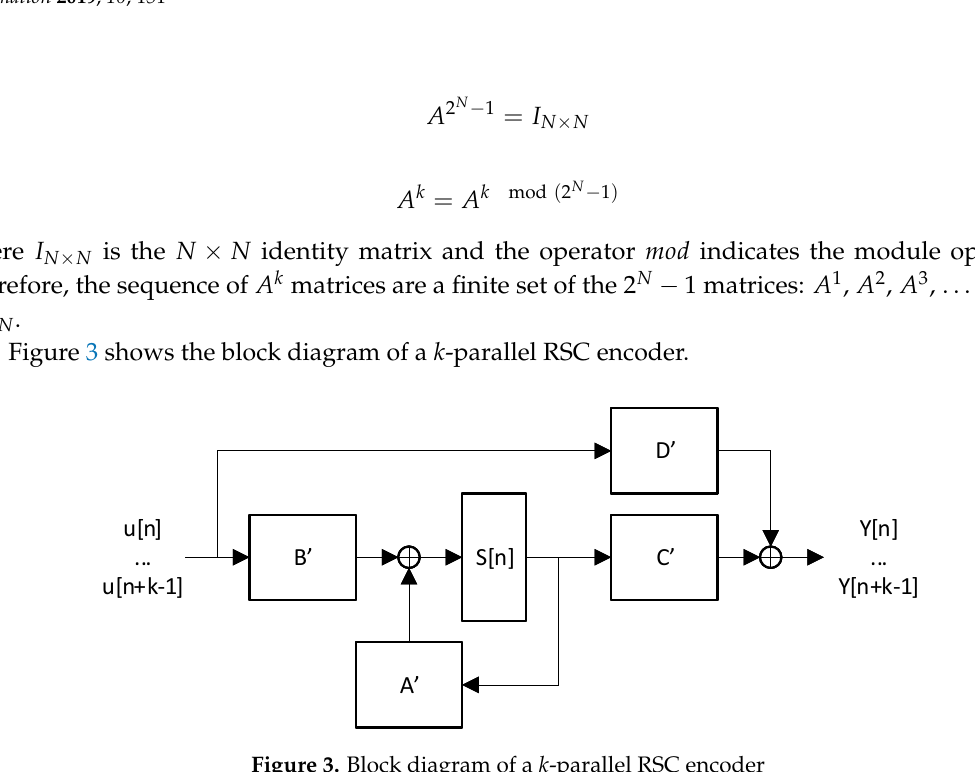
Figure 3. Block diagram of a k -parallel RSC